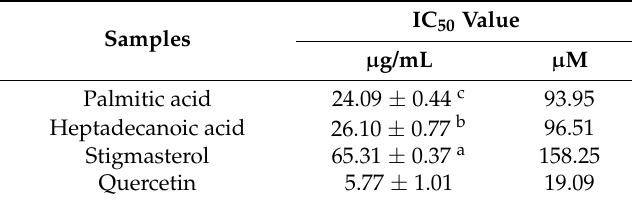
Table 3. The half maximal inhibitory concentration (IC 50 ) of α -glucosidase inhibitory activity of quantified reference compounds.